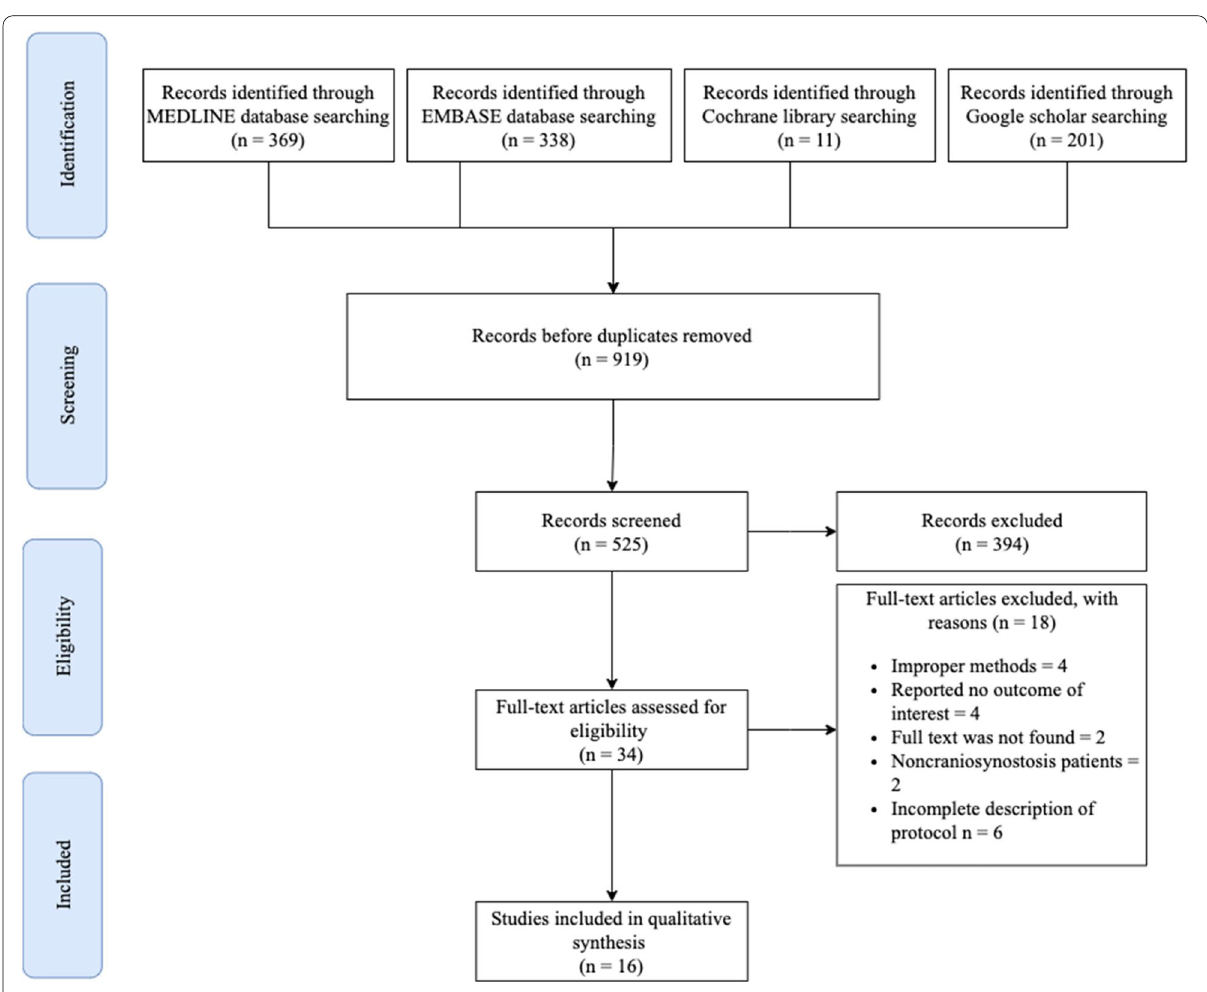
Fig. 1 The PRISMA flowchart for systematic review. The process of selecting the included